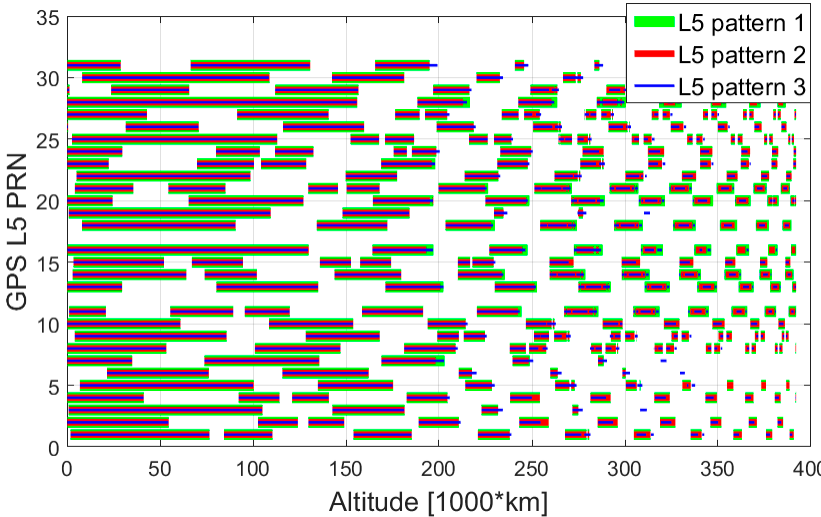
Figure 23. Available GPS L5 signals, during the assumed MTO, for a 10 dBi receiver gain pattern.